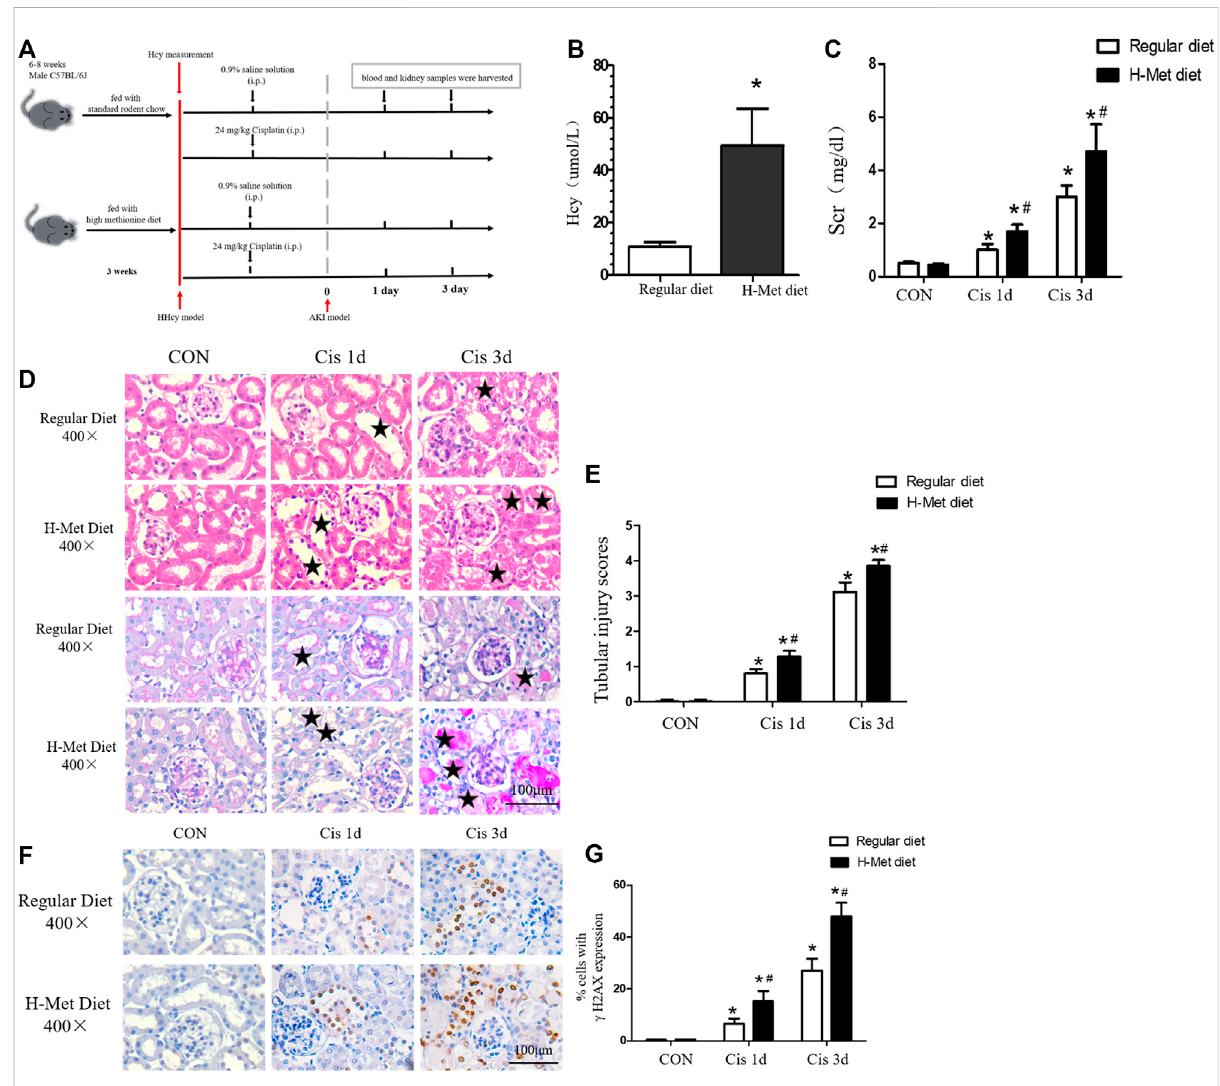
FIGURE 1 Mice with HHcy are more susceptible to cisplatin-induced acute kidney injury. (A) Timeline of mouse experiment. (B) Plasma level of homocysteine (Hcy) in mice. (C) Level of serum creatinine (Scr) at days 1 and 3 after cisplatin injection. (D) Representative kidney histology of H&E staining and periodic acid – Schiff staining at days 1 and 3 after cisplatin injection (scale bar, 100 μ m; magni fi cation, ×400). Black stars ( ) indicate tubular damage in renal tissue, including tubular dilatation, tubular casting formation, cell necrosis, and brush edge loss. (E) Statistical quanti fi cation analysis showing injury score of H&E staining. (F) Representative images of immunohistochemical staining show γ H2AX-positive kidneycellsinatdays1and3aftercisplatininjection(scalebar,100 μ m;magni fi cation×400). (G) Quantitativedeterminationof γ H2AX-positivecells. Data expressed as mean ± SD; n = 5 – 7 per group. * p < 0.05 versus control; # p < 0.05 versus mice fed with regular